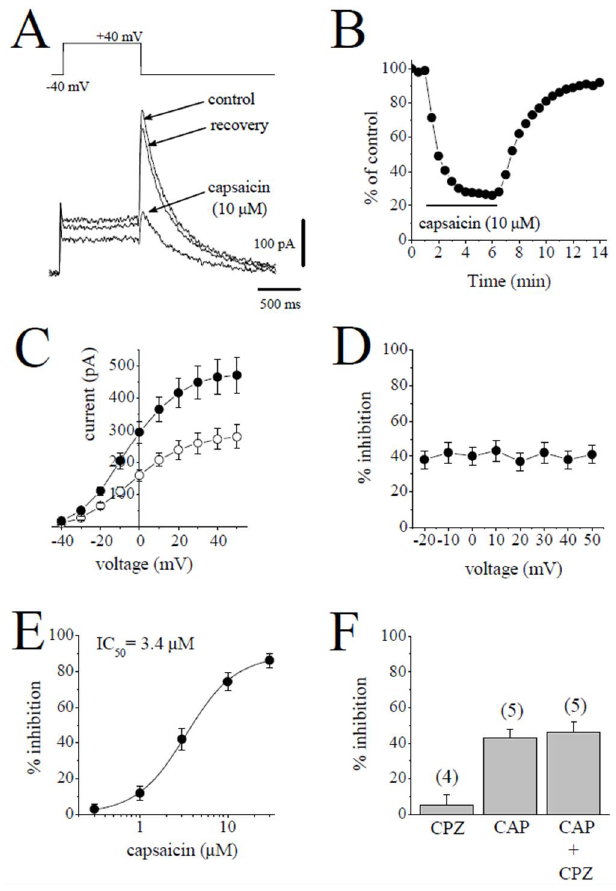
Figure 3. Capsaicin suppresses the I Kr tail current. ( A ). Superimposed current traces in control, after 6 min exposure to 10 µM capsaicin and recovery. I Kr tails were measured as a time-dependent component of the tail current activated in response to membrane repolarization. The pulse protocol to activate I Kr is presented as an inset. ( B ) Time course of the effect of capsaicin effect on the maximal amplitudes of I Kr and washout presented as % of control calculated from the mean of three control currents ( n = 5). ( C ) Current–voltage relationships of I Kr in absence (filled circles) and presence (open circles) of 3 µM capsaicin are shown ( n = 6). ( D ) The relationship between test potential and the capsaicin (3 µM) inhibition of I Kr ( n = 6; p > 0.05, ANOVA). ( E ) Concentration-inhibition curve for capsaicin inhibition of I Kr tails ( n = 4–8). ( F ) The effect of capsazepine (3 µM) alone and the extent of capsaicin (3 µM) inhibition of I Kr in the absence and presence of 3 µM capsazepine. The number of cells tested for each group was presented on top of each bar ( p > 0.05; t -test).